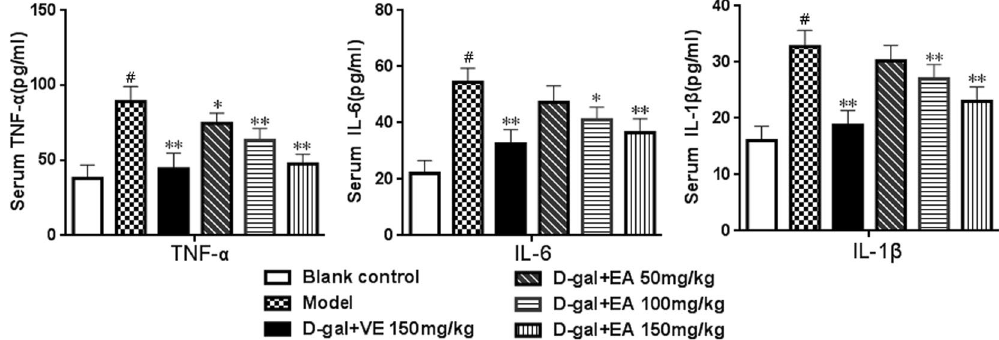
Figure 3. Effects of EA on the levels of TNF- α , IL-6 and IL-1 β in sera of rats. The levels of pro-inflammatory were determined by ELISA kits. Values are given as mean ± SD from each group(n = 8). # P < 0.01 vs blank